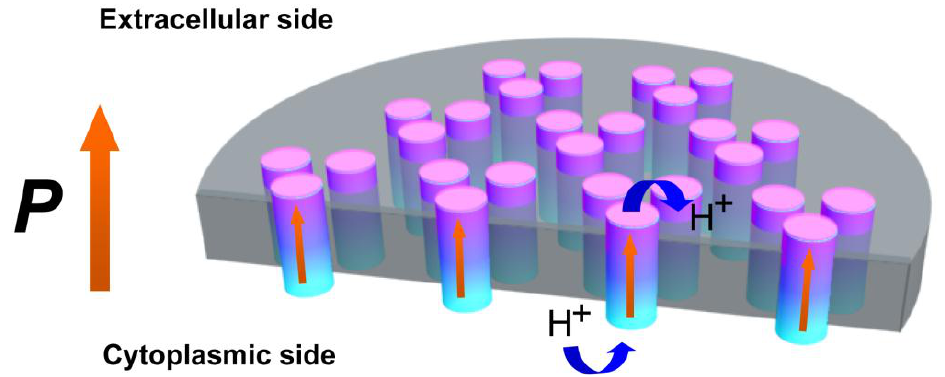
Figure 4. Proposed model of internal structure and potential difference in PM.